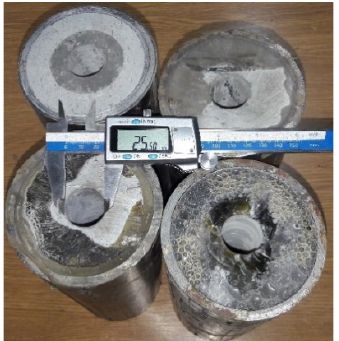
Figure 8. Rock cores (dolomites) installed to steel cylinders.